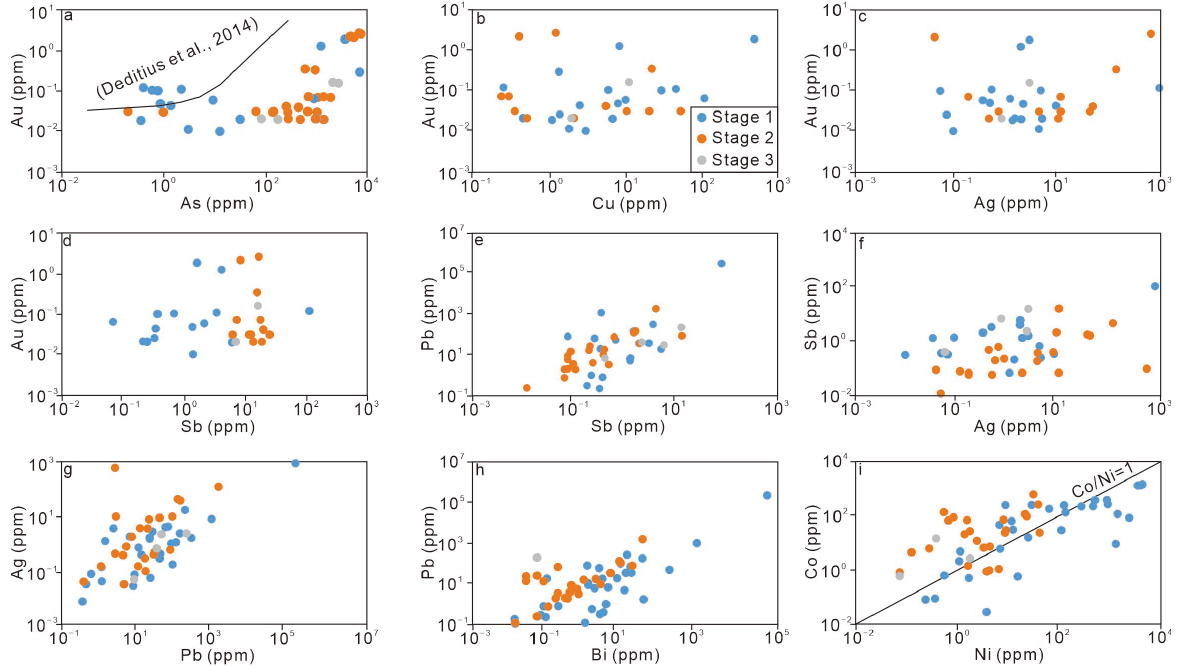
Figure 9. Binary plots of ( a ) Au vs. As, ( b ) Au vs. Cu, ( c ) Au vs. Ag, ( d ) Au vs. Sb, ( e ) Pb vs. Sb, ( f ) Sb vs. Ag, ( g ) Ag vs. Pb, ( h ) Pb vs. Bi, and ( i ) Co vs. Ni of Py1 to Py3.